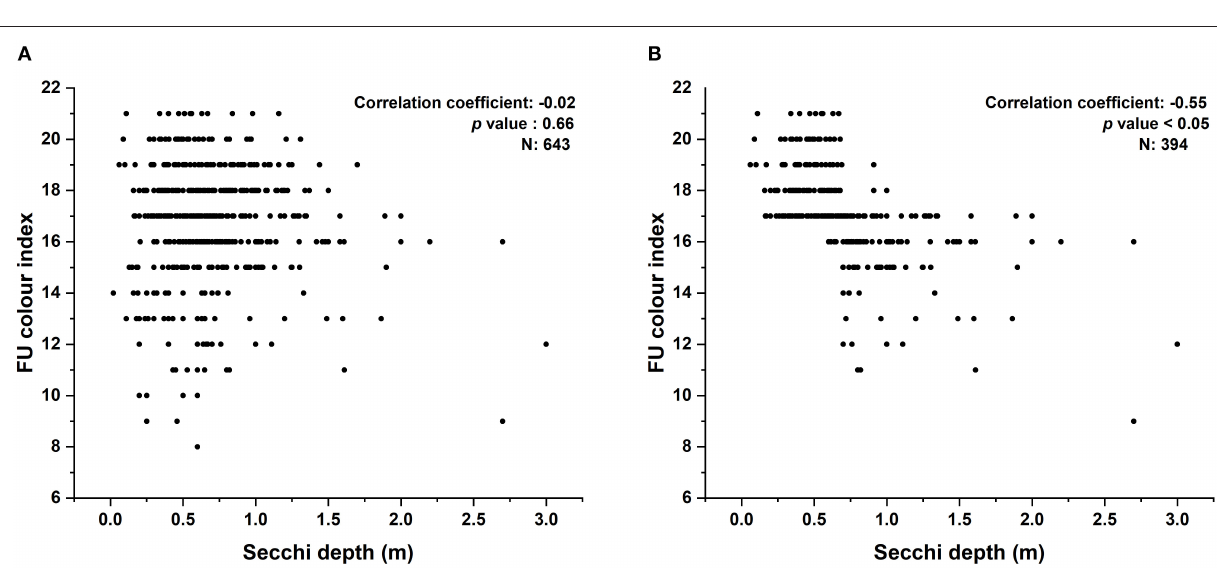
FIGURE 9 | Correlation between FU index and Secchi depth obtained using the MSD. (A) Using the entire data collected by citizens ( N = 643). (B) After removing outliers ( N = 394). Relation became statistically significant ( p < 0.05) after removal of outliers.